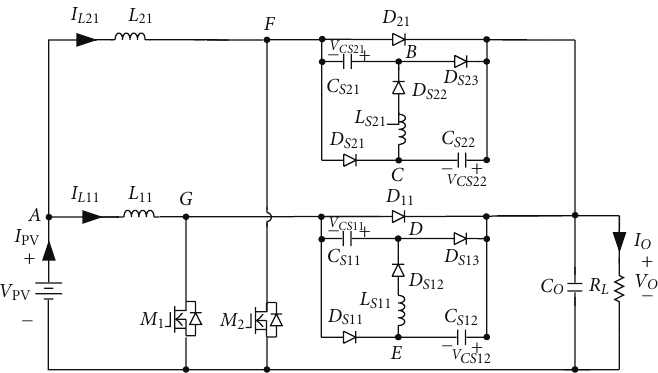
Figure 3: Topology of two sets of boost converters operated in an interleaving fashion.